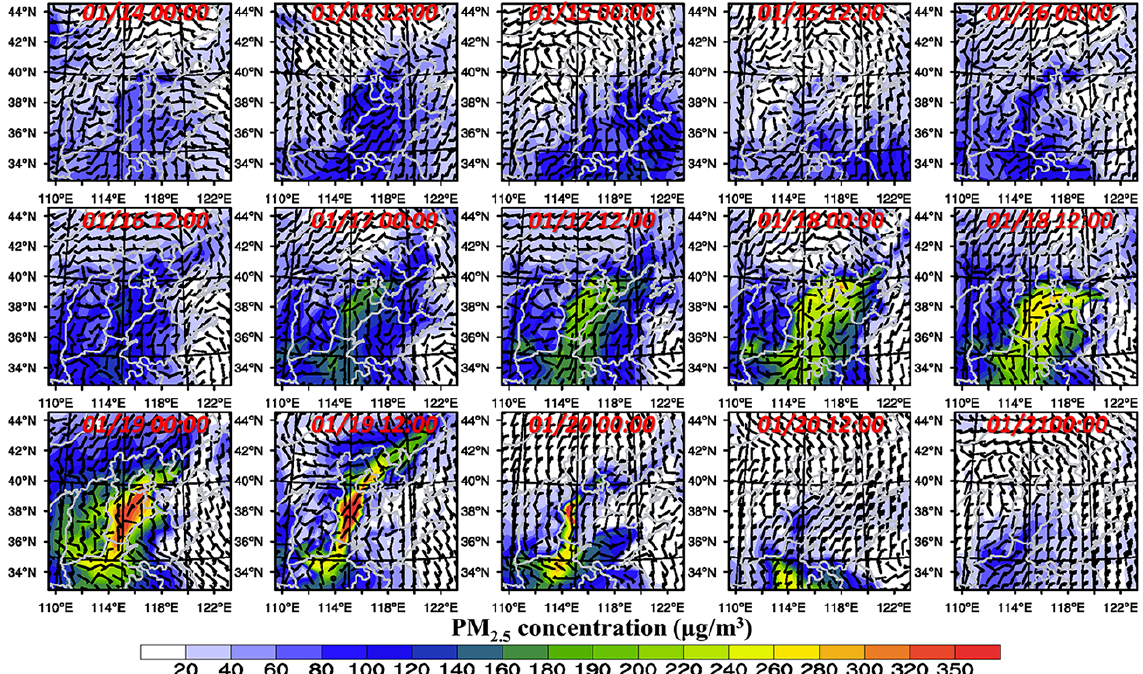
Figure 6. PM 2 . 5 concentration from 14 January 00:00 to 21 January 00:00, plotted every